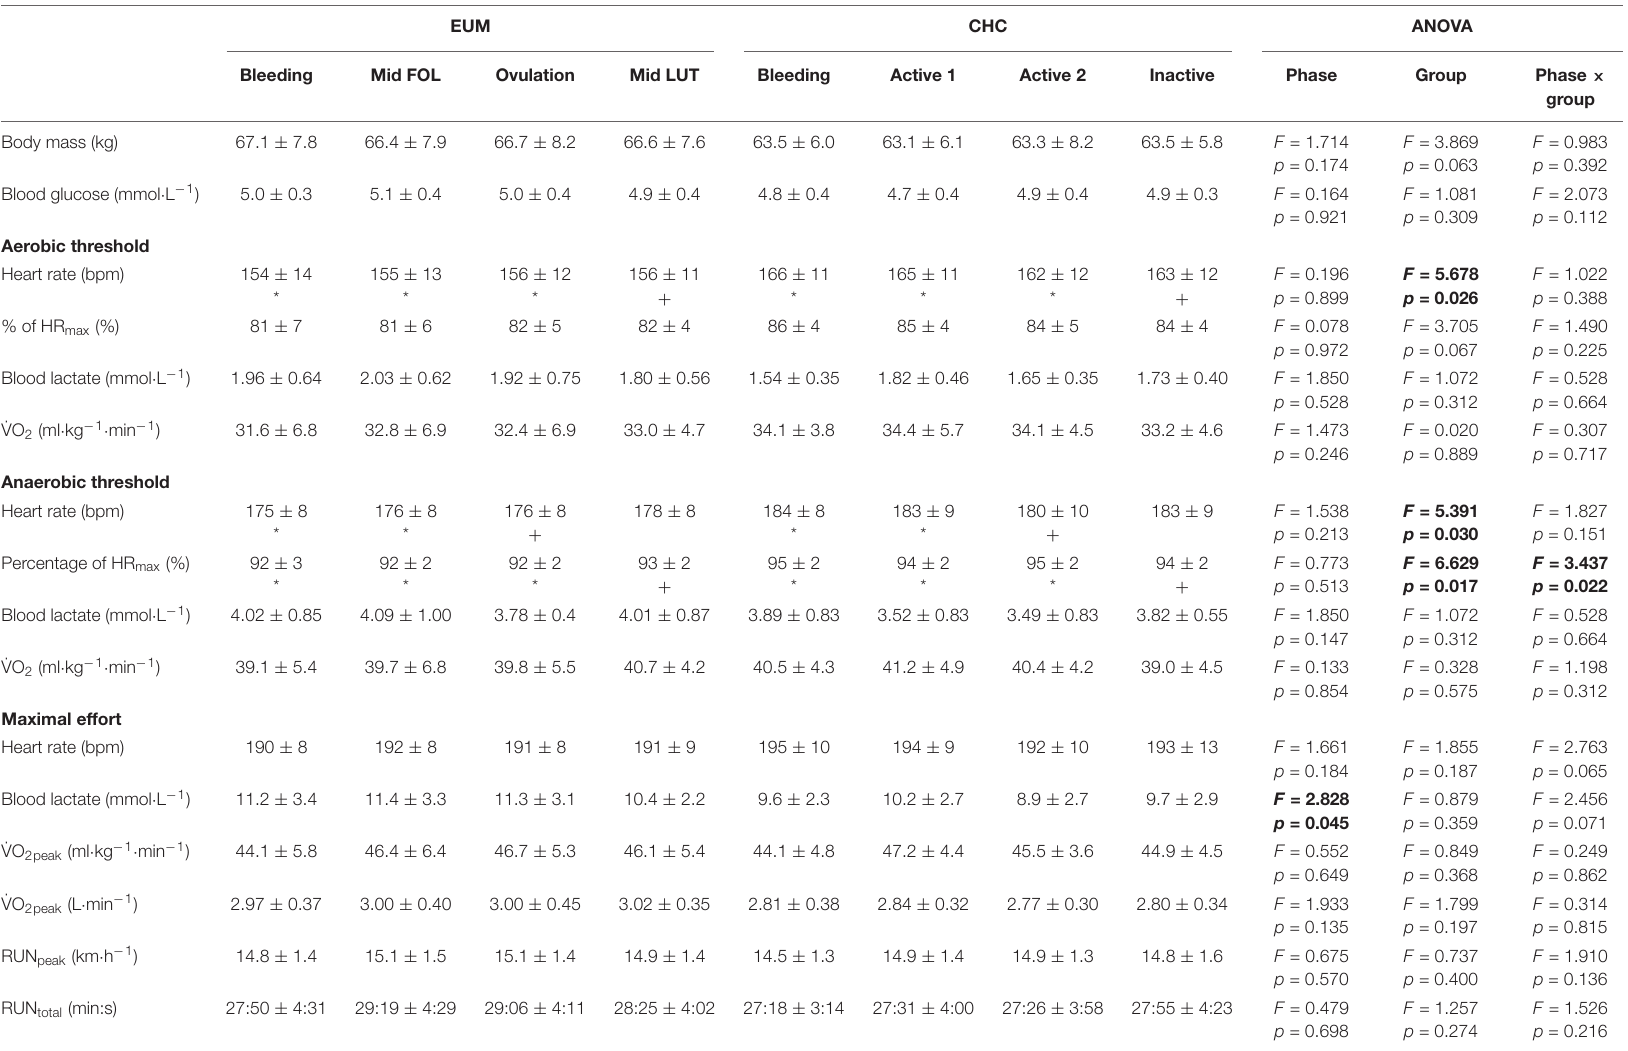
TABLE 4 | Heart rate, blood lactate, and ˙VO 2 at aerobic and anaerobic thresholds as well as maximal effort across the four cycle phases for the eumenorrheic (EUM) and the hormonal contraceptive (CHC)